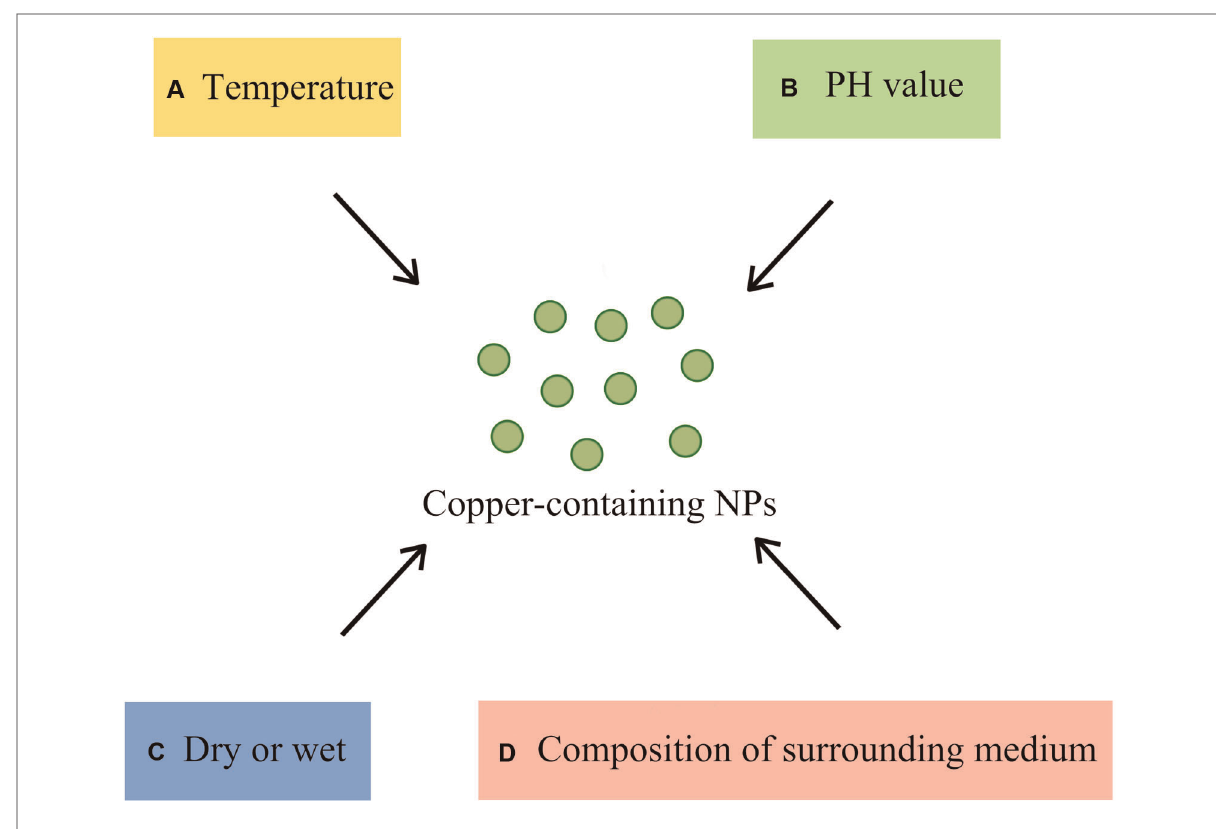
FIGURE 3 Ambient conditions affecting the antibacterial effect of Copper-containing NPs ( A ) temperature: the higher the temperature, the faster the sterilization; ( B ) PH value: the sterilization of acidic and alkaline conditions is faster than that of neutral conditions; ( C ) Dry or Wet: dry conditions kill bacteria faster than wet conditions; ( D ) composition of the surrounding medium: interaction of NPs with other molecules in the